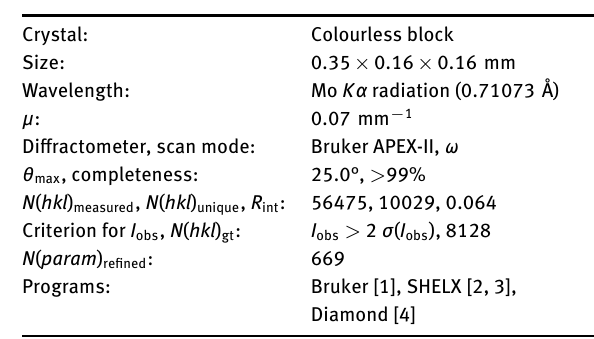
Table 1: Data collection and handling.